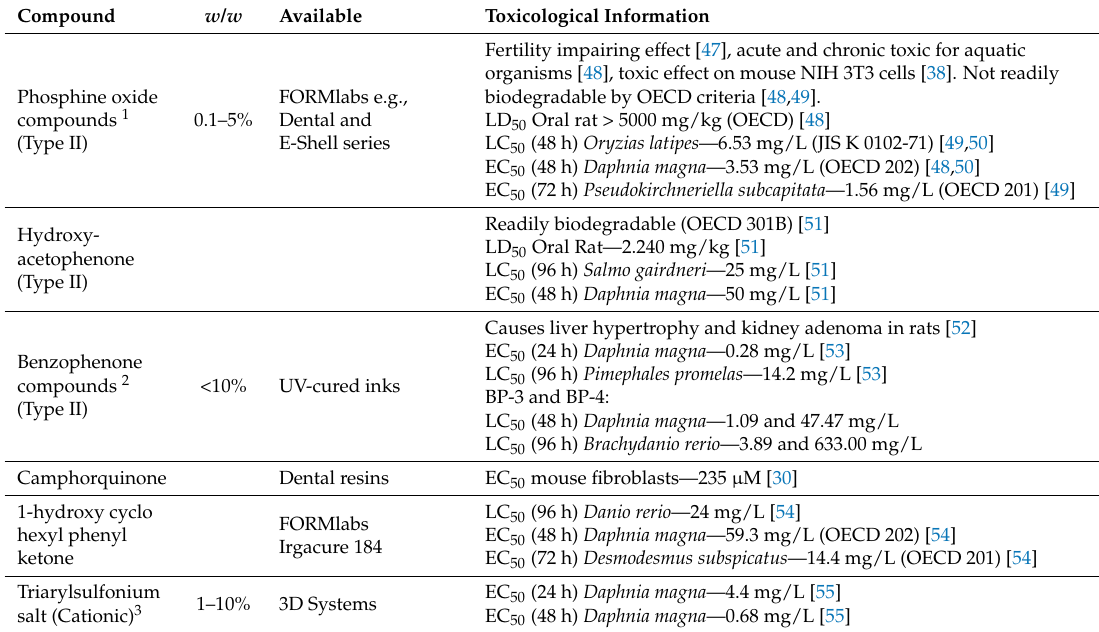
Table 1. Summary of toxicity data available for photoinitiators used in stereolithography